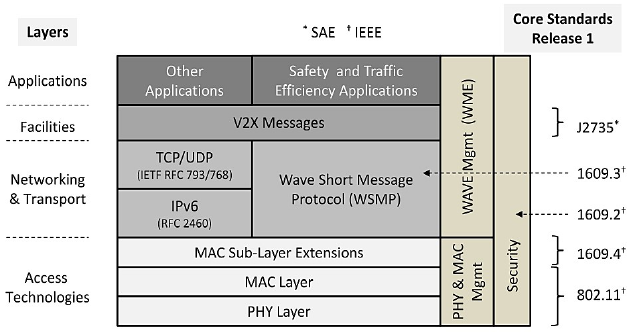
Fig. 6. DSRC protocol stack